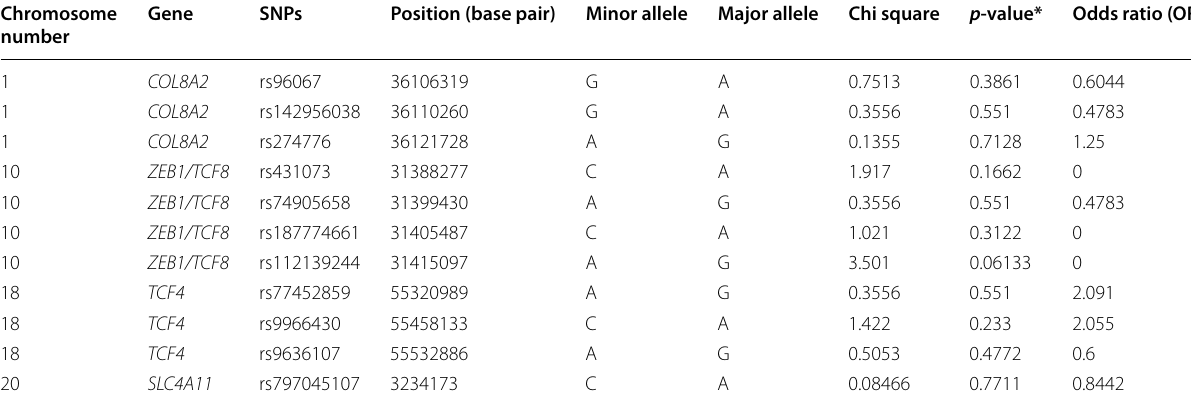
Table 3 Association of candidate genes with FECD